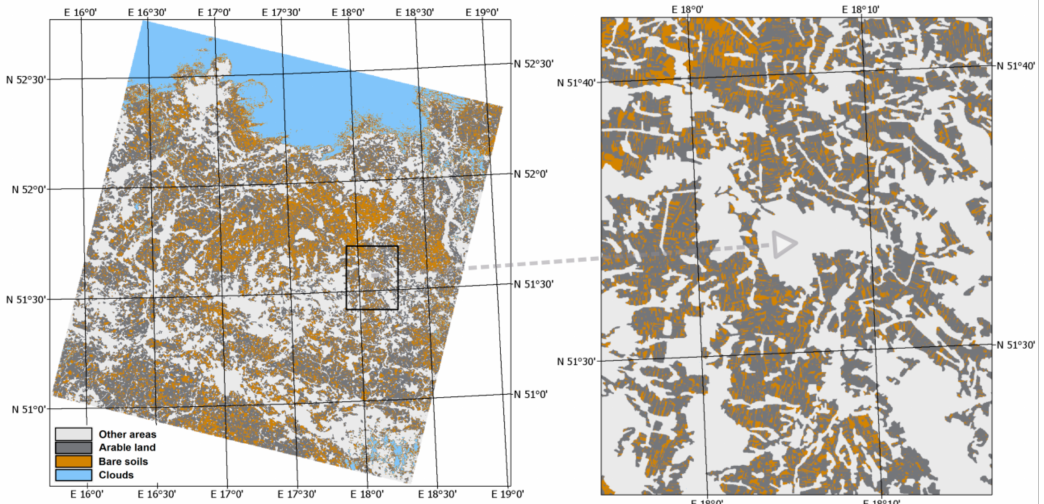
Figure 2. Bare soil areas extracted from Landsat 8 image in 190/24 scene, recorded on 1 March 2014 within arable land contours in Poland.